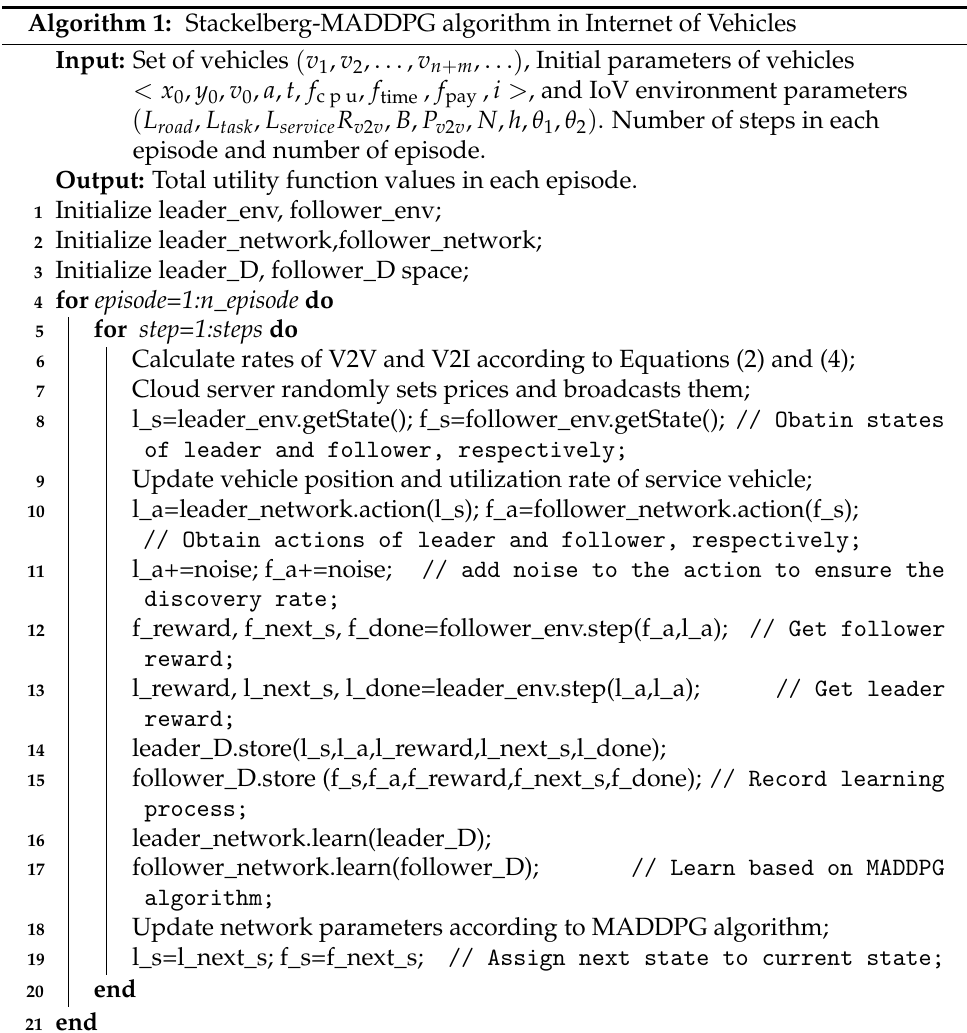
Algorithm 1 shows the pseudo-code of the Stackelberg–MADDPG. Algorithm 1: Stackelberg-MADDPG algorithm in Internet of Vehicles